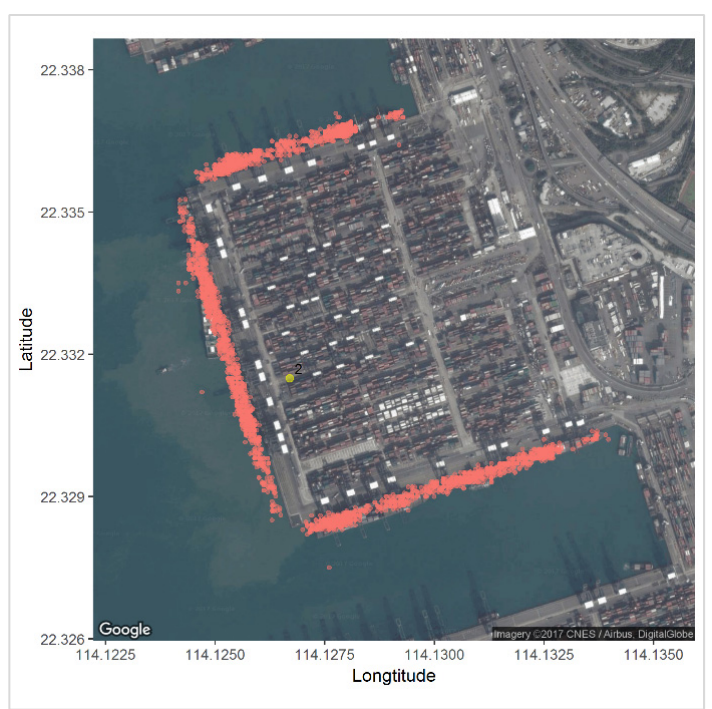
Figure 2. A typical satellite imagery of a container terminal with large number of Automatic Identification Systems (AIS) data points reported from ships then stay at the terminal.